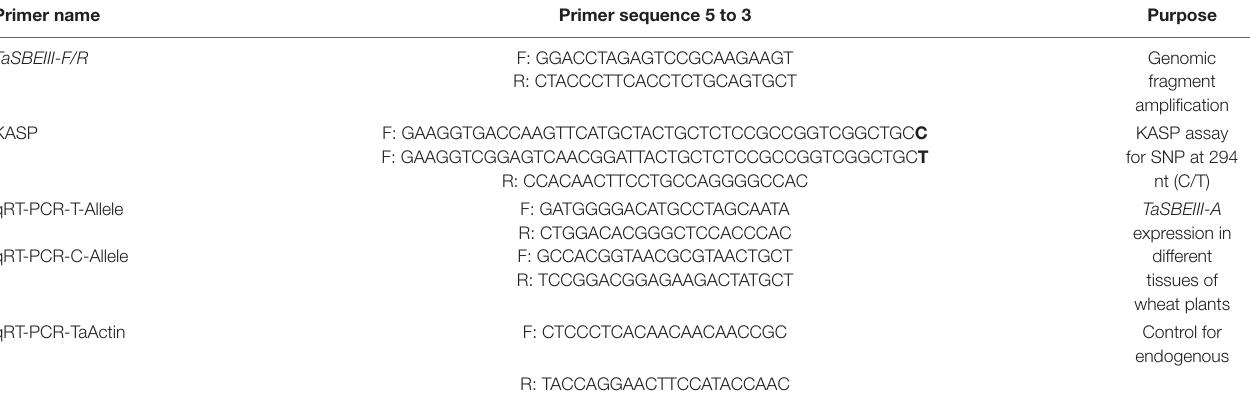
TABLE 1 | Primers used in the